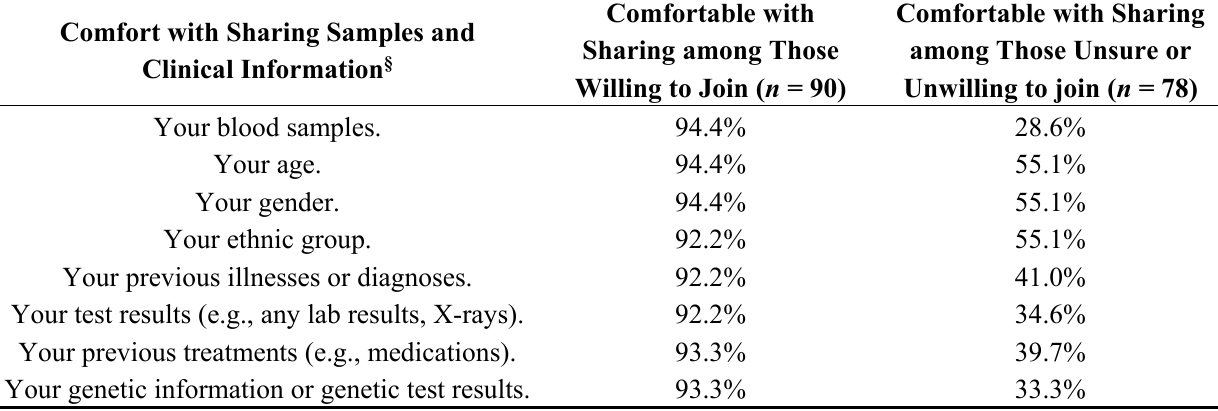
Table 2. Willingness to join according to comfort sharing samples and clinical information. Comfort with Sharing Samples